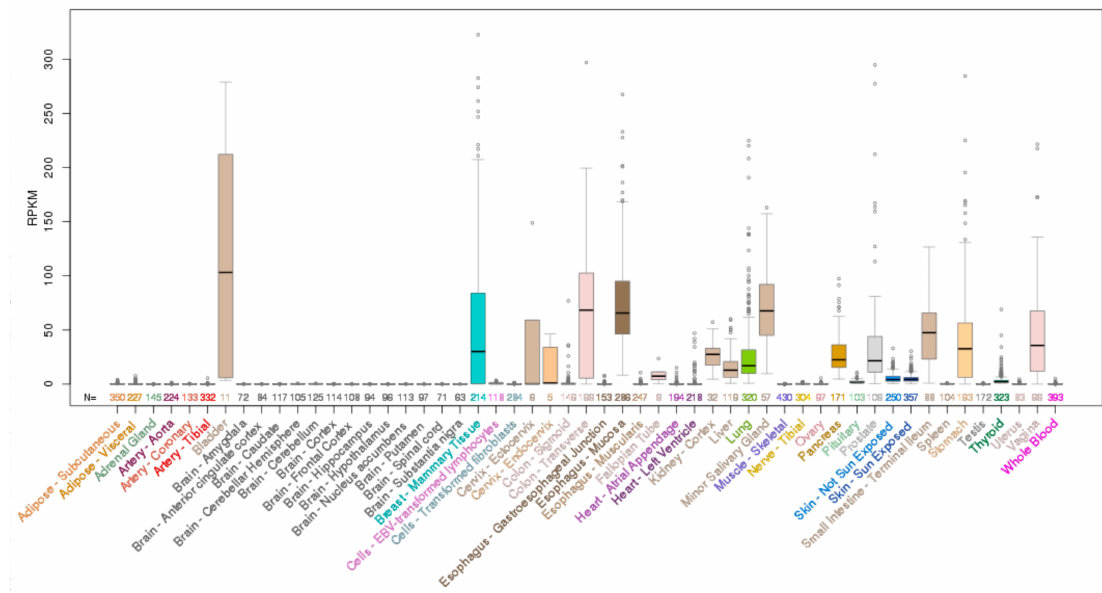
Figure 2. Expression of ELF3 mRNA across normal human tissues. Data obtained from University of California Santa Cruz (UCSC) genome